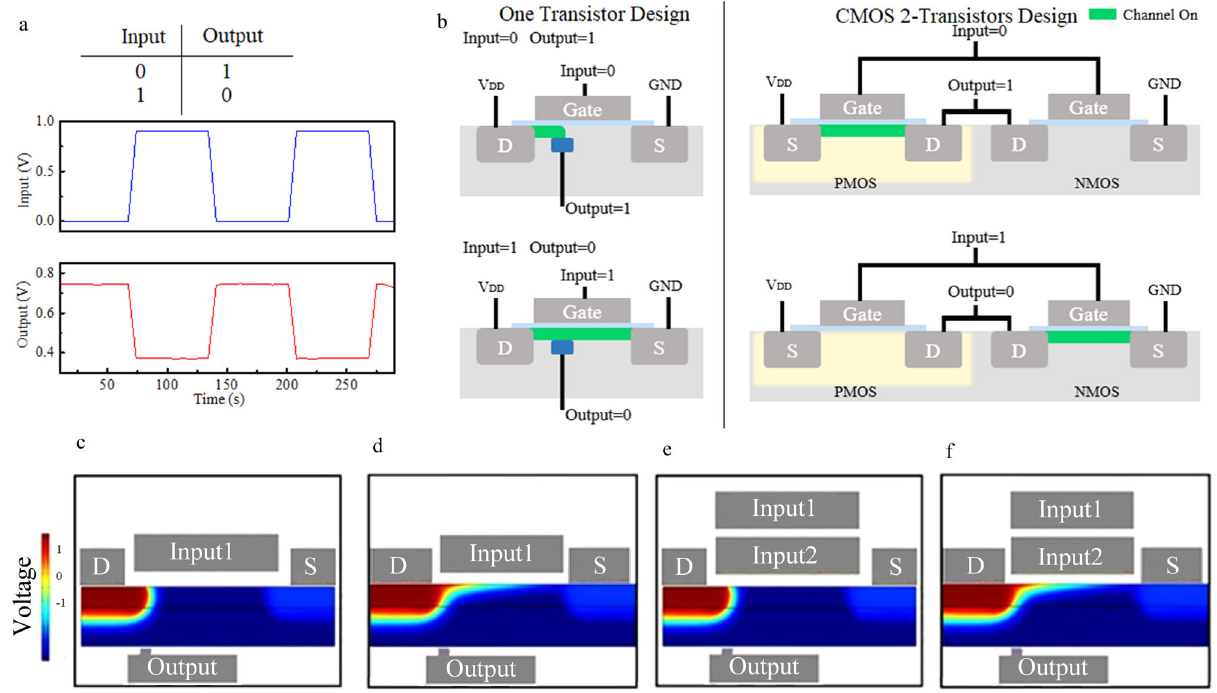
Fig. 2 One-transistor logic NOT gate structure, mechanism and simulation of the one-transistor design. Please kindly note that the simulation results are used to describe the mechanisms qualitatively and the two input gates functions and effects are considered to be the same to those of the one input gate. a Measured input gate voltage vs. output voltage. V DS = 0.9 V. b Mechanism comparison of logic NOT for both the MGT structure and the conventional CMOS (complementary Metal Oxide Semiconductor transistors) structure. c – f Simulation results of voltage distribution in the one-transistor design. c , e The input gate voltages turn the channel off, and the gate-to-drain voltage enables the high voltage region on the drain edge to extend from the drain to the output for logic NOT and logic NAND, respectively. d , f The input gate voltage turns the channel on so that the output voltage is drawn down by the source voltage, for logic NOT and logic NAND,